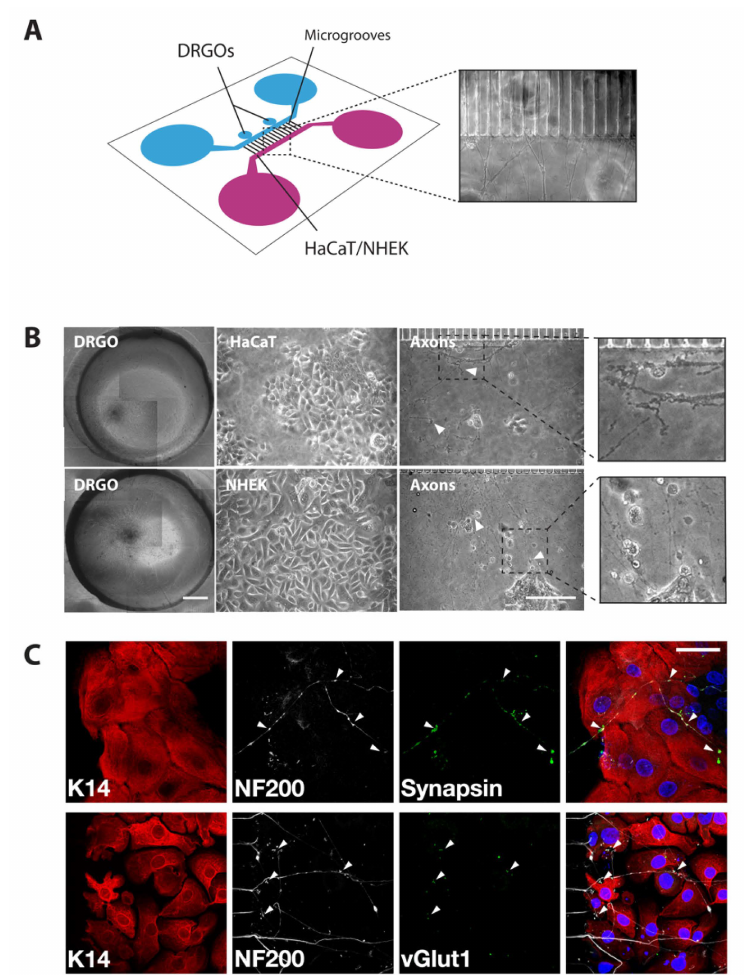
Figure 1. Coculture of DRGOs and keratinocytes on a chip. ( A ) Graphical representation of microflu- idics chip and bright-field image (20 × magnification) of axonal extensions from DRGO chamber to NHEK chamber through microgrooves. ( B ) Bright-field microscopy images of cells cocultured in microfluidic chips, with neuron-to-cell connection (white triangles). Scale bars: DRGO, 200 µ m; HaCaT/NHEK/axons, 100 µ m. ( C ) Immunofluorescence analysis of free nerve ending neuron-to-cell connection (arrowheads) using K14 (red), NF200 (white), synapsin (green, up), and vGlut1 (green, down). Total nuclear DNA is counterstained with Hoechst (blue). Scale bar, 50 µ